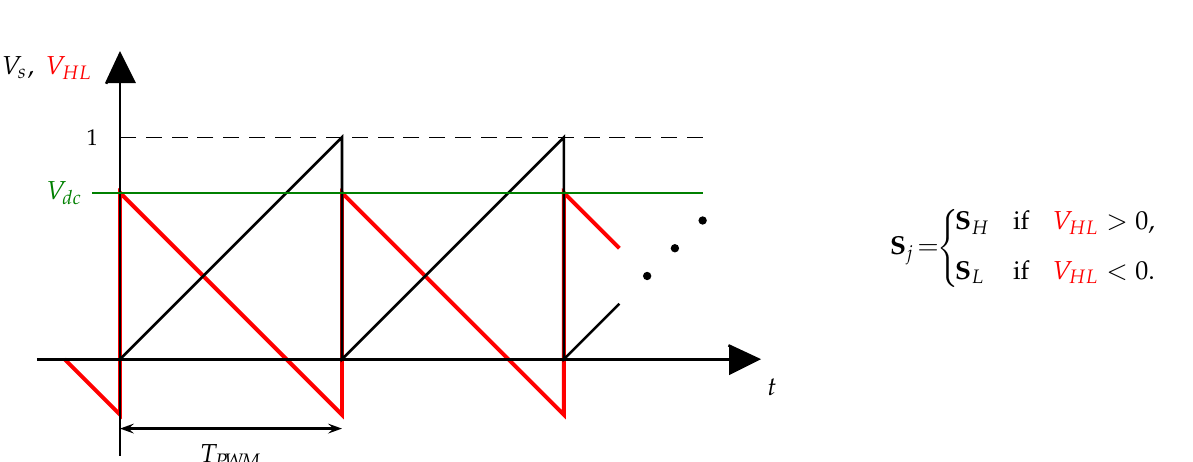
Figure 25. Scheme for the application of the configuration vectors S j time intervals T H and T PWM higher and lower level time intervals T